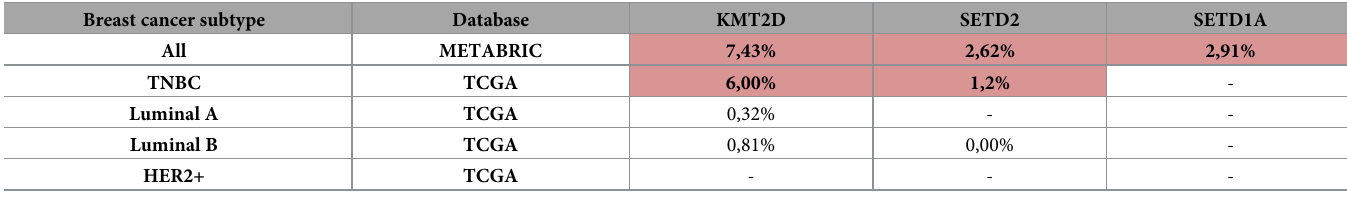
Table 1. Proportion of mutations in the TCGA and METABRIC databases. Breast cancer subtype